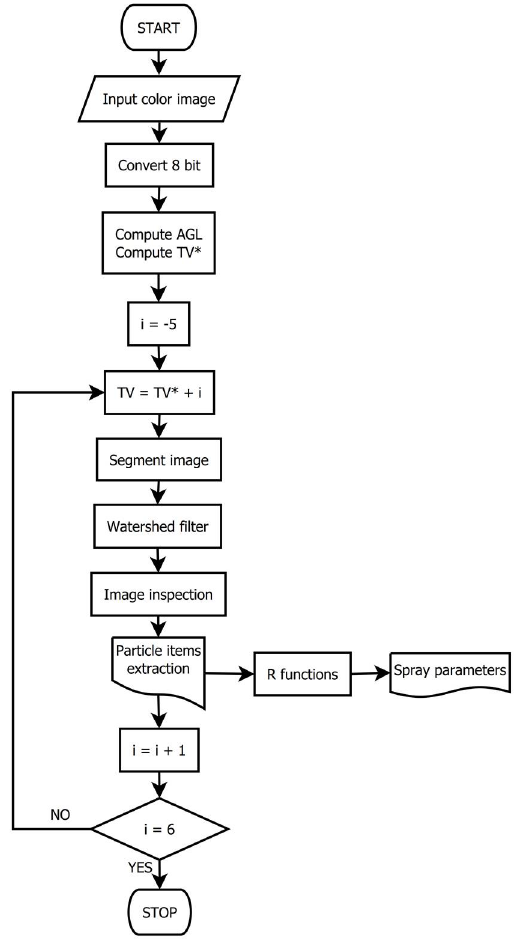
Figure 3. Flow chart of the image analysis procedure. Each image was segmented 11 times with 11 different threshold values (TV), computed in function of the average gray level (AGL) of the image and the threshold value TV ∗ predicted by Equation (10).